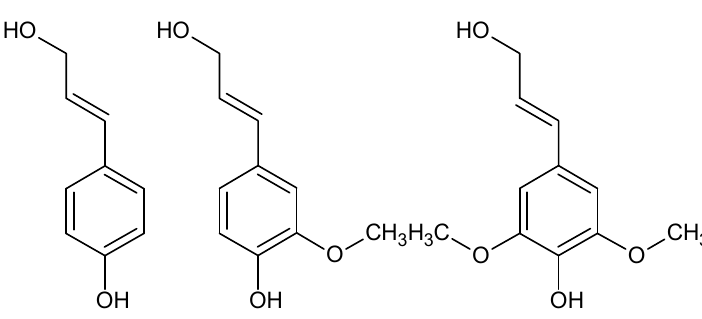
Figure 2. The main phenols from lignin adapted from reference [7].